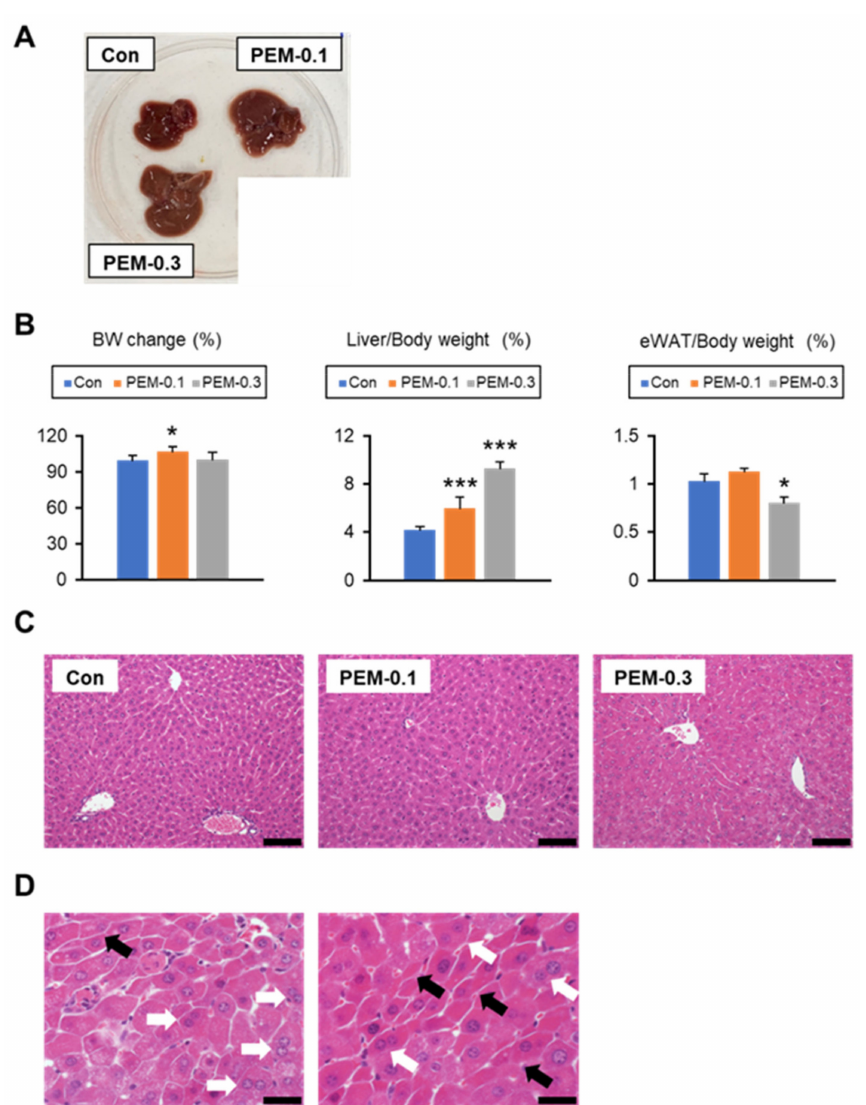
Figure 1. Phenotypic changes after 2-week PEM treatment at a clinically relevant dose (0.1 mg/kg/day) or relatively high dose (0.3 mg/kg/day). ( A ) Gross appearance of the liver. ( B ) Body weight (BW) change and the ratio of liver and epididymal white adipose tissue (eWAT) weight to BW. ( C ) Representative photomicrographs of hematoxylin and eosin-stained liver sections. Scale bar = 50 µ m. ( D ) Hepatic sinusoidal narrowing (black arrow) and binuclear cells (white arrow) were found in liver tissue sections in the relatively high PEM group. Scale bar = 20 µ m. Data are expressed as the mean ± SD. * p < 0.05 and *** p < 0.001 vs. control group. Con, vehicle-treated mice; PEM-0.1, pemafibrate-treated mice at a clinically relevant dose (0.1 mg/kg/day); PEM-0.3, pemafibrate-treated mice at a relatively high dose (0.3